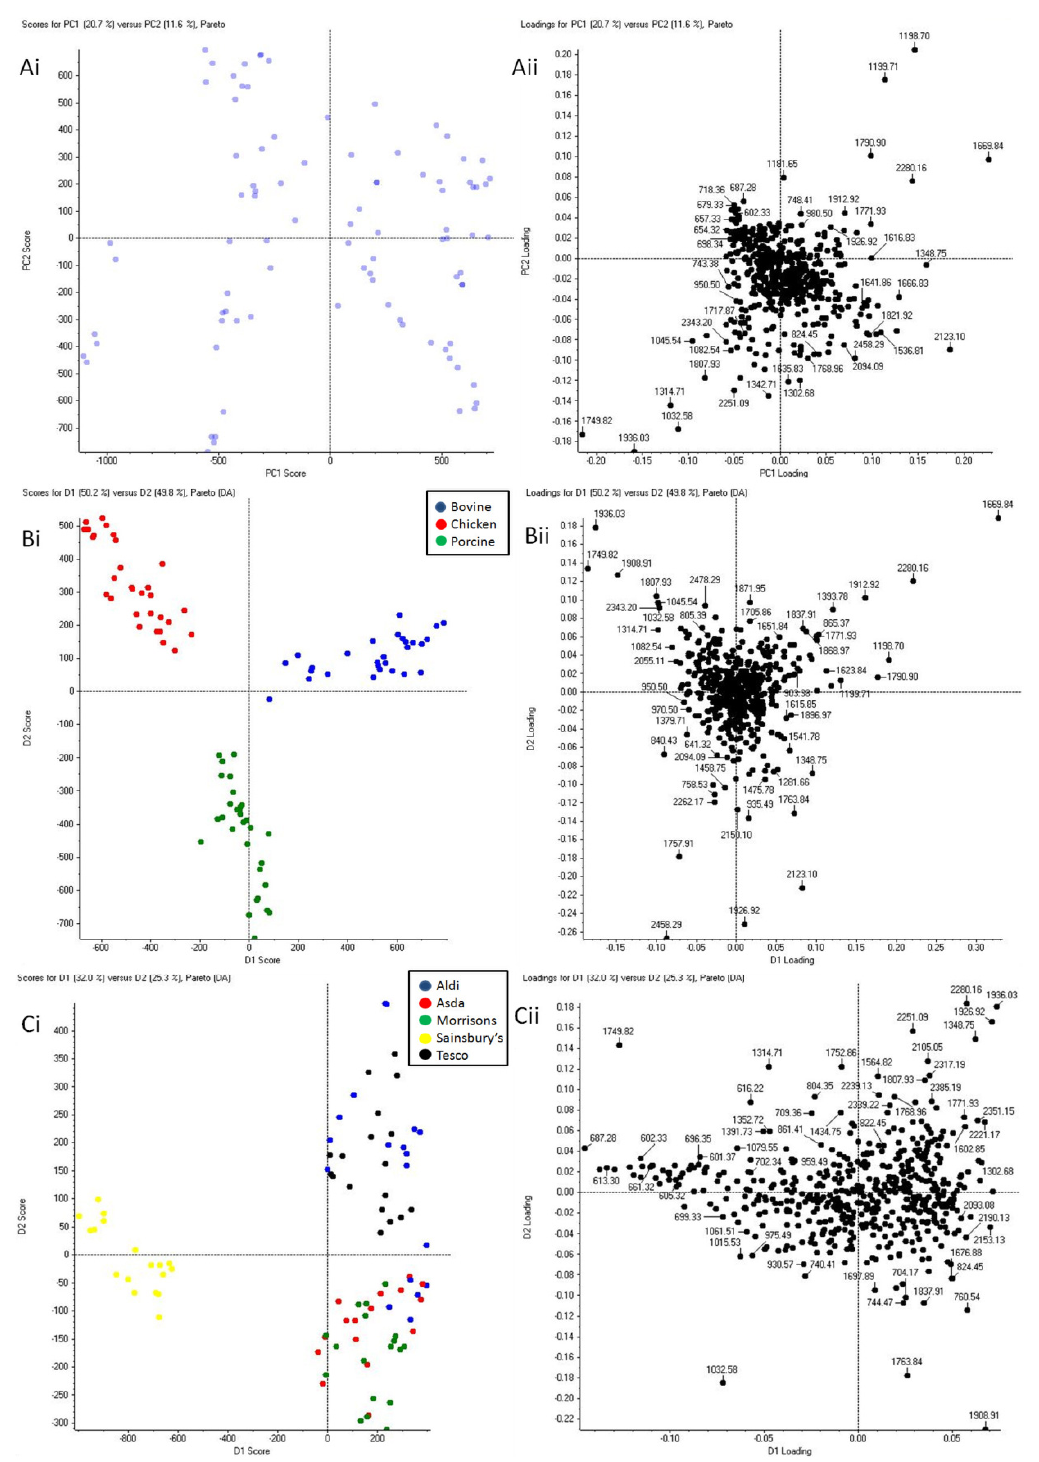
Figure 5. Principal component analysis of bovine, chicken and porcine blood collected from raw packaged meat (from five supermarkets in total: Asda, Aldi, Morrison’s, Tesco, and Sainsbury’s). Six replicate spectra from each in solution packaged meat animal blood proteolysis were used for the statistical analysis. Panels ( Ai , Aii ) are the unsupervised PCA plots; Panels ( Bi , Bii ) are the supervised PCA plots with grouping based on meat types; Panels ( Ci , Cii ) are the supervised PCA plots with grouping based on supermarkets.